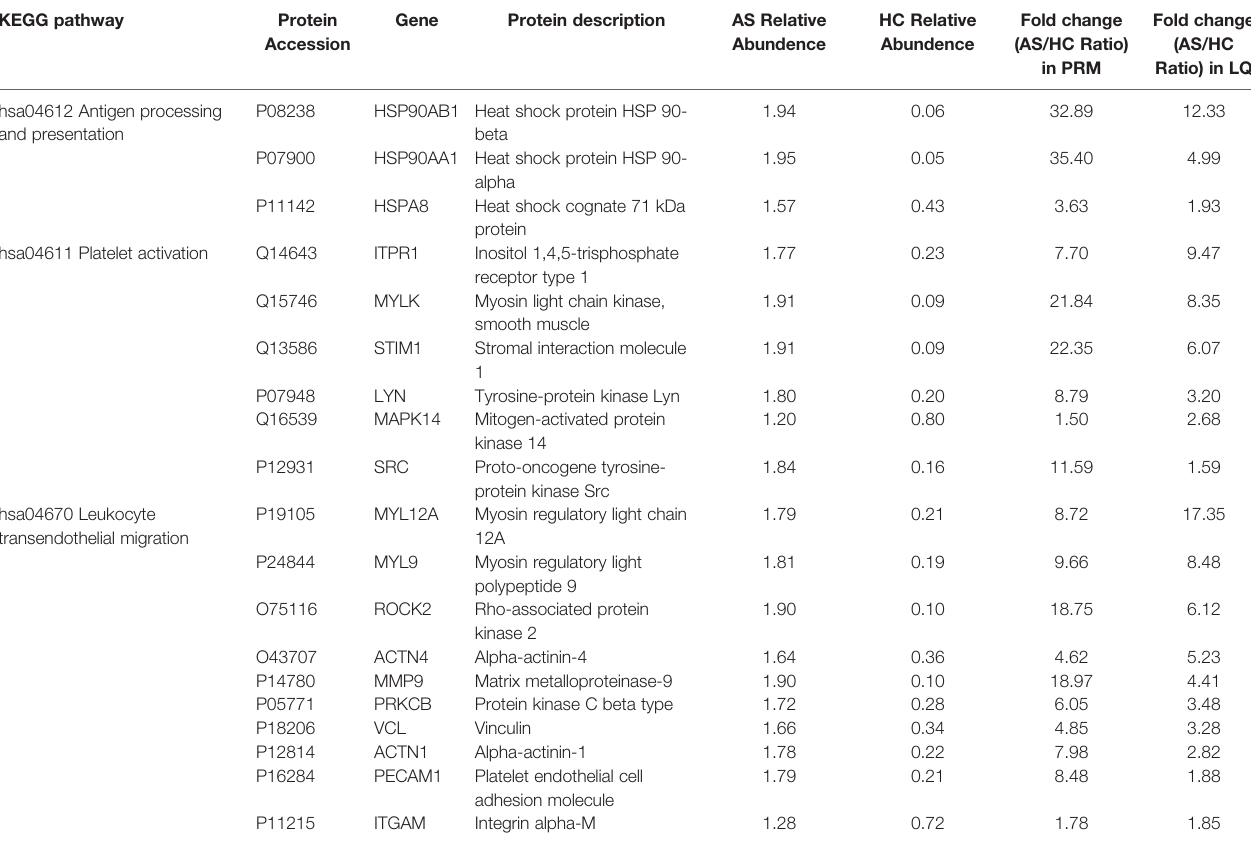
TABLE 1 | Veri fi cation results of target proteins. KEGG pathway Protein